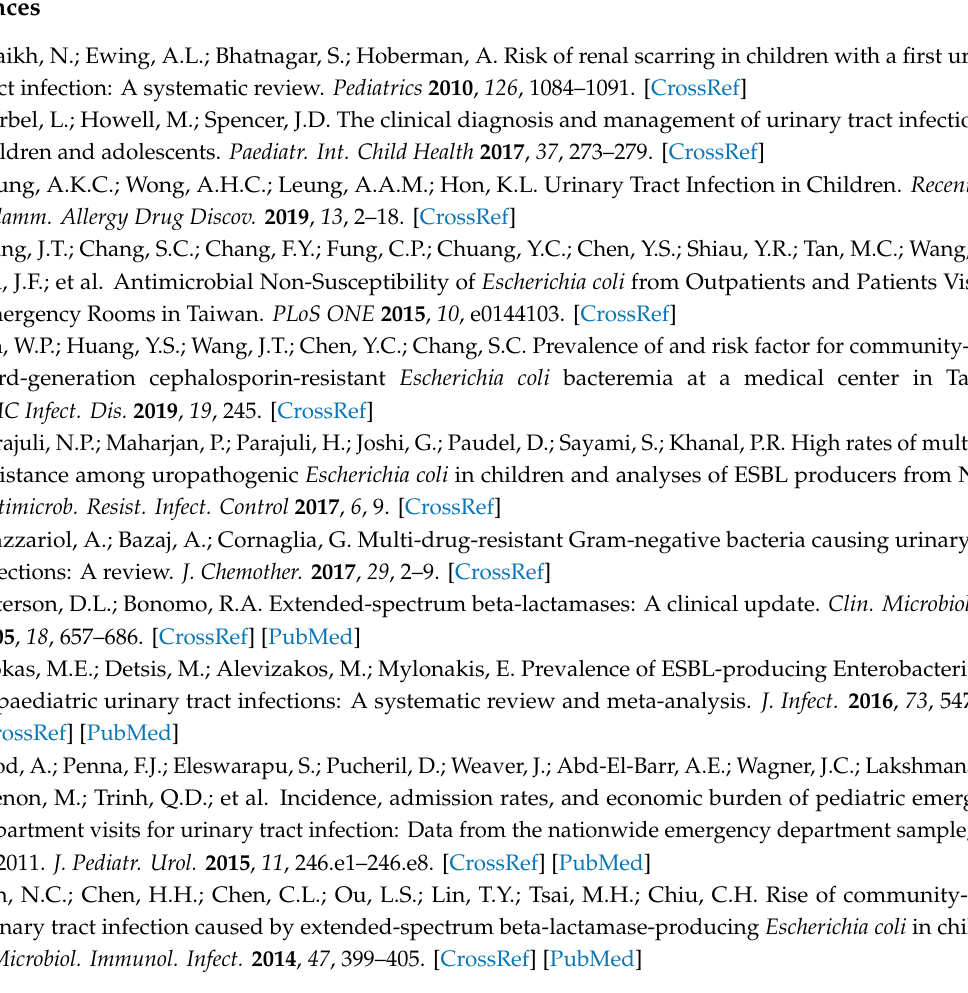
Figure S1: Trends of overall E. coli (single and polymicrobial) in community-associated UTIs among children aged < 18 years, 2004–2018 (IRR: 1.01 95% CI (0.99–1.02), p = 0.3855). Figure S2: Trends of antibiotic resistance of overall E. coli (single and polymicrobial) in community-associated UTIs among children aged < 18 years, 2004–2018. Table S1: Codes and definitions for the study cohort. Table S2: Annual hospital Admissions and E. coli single isolated uropathogen UTIs. Table S3: Characteristics of incident E. coli UTI cohort between community- and healthcare-associated subgroups ( n = 7696). Table S4: Comorbid condition of the E. coli community-associated UTI